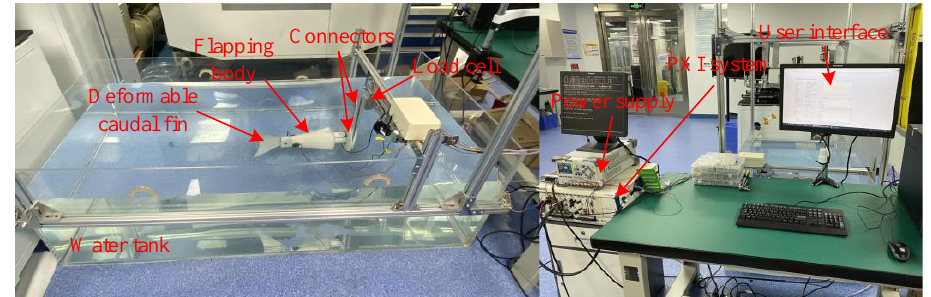
Figure 3. Experimental Platform.